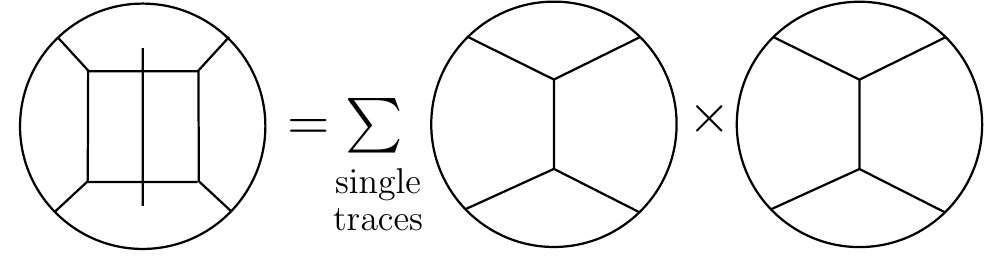
Figure 1 . Correlators in any large- N theories can be fully reconstructed from singularities (denoted by the cut) that are saturated by single-trace operators. Theories with a gravity dual correspond to the case where the sum is e(cid:11)ectively (cid:12)nite.